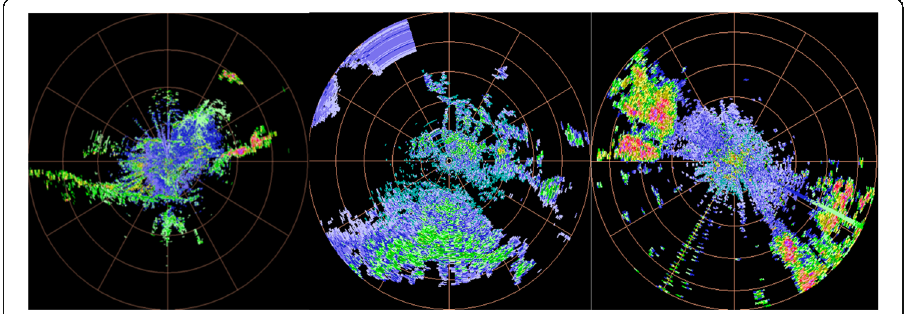
Fig. 1 Examples of abnormal radar echo